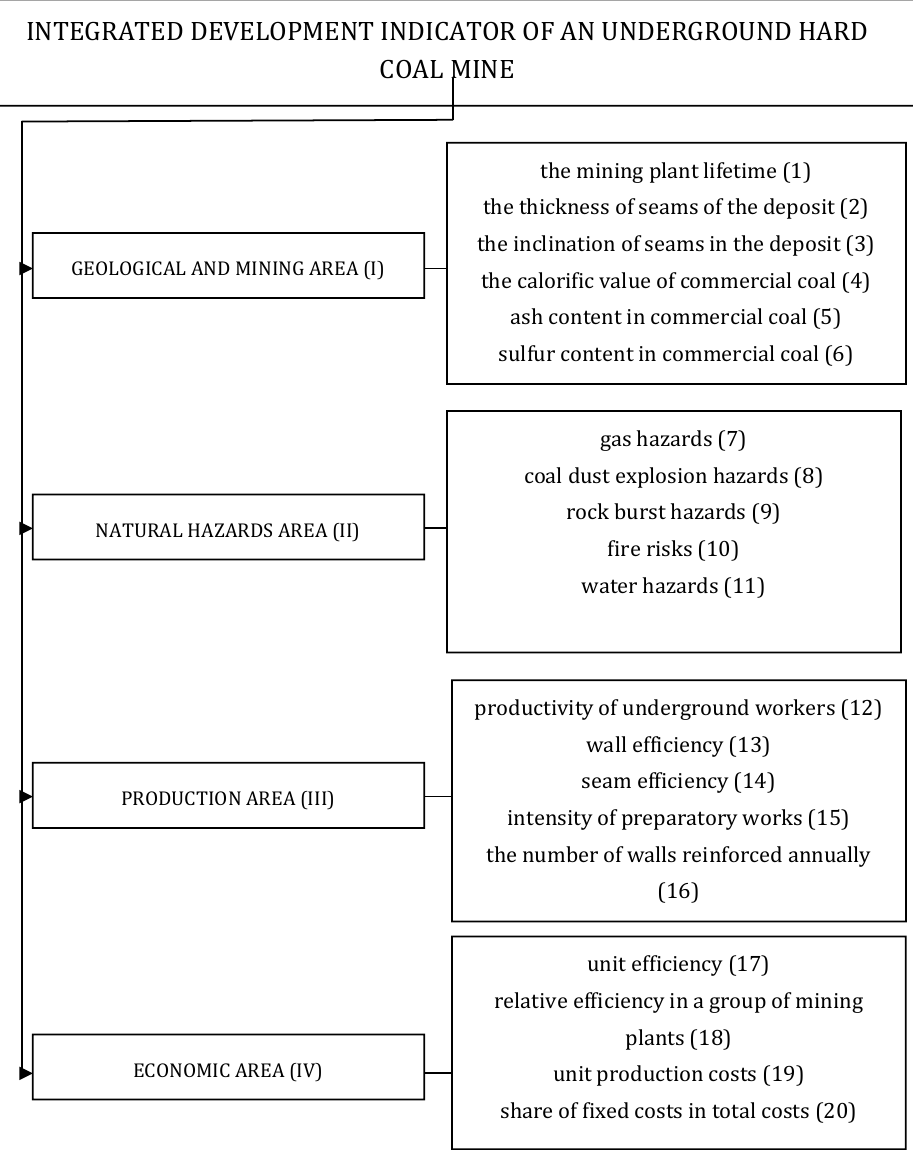
Figure 1. Areas and criteria for the construction of an integrated indicator for assessment of the development of an underground hard coal mine. Own study.